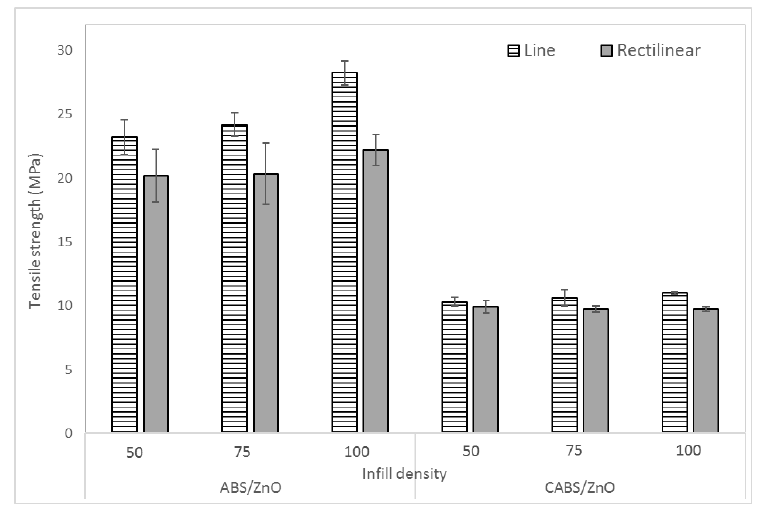
Figure 4. Effect of infill density and printing pattern on tensile strength of ABS/ZnO and CABS/ZnO samples.